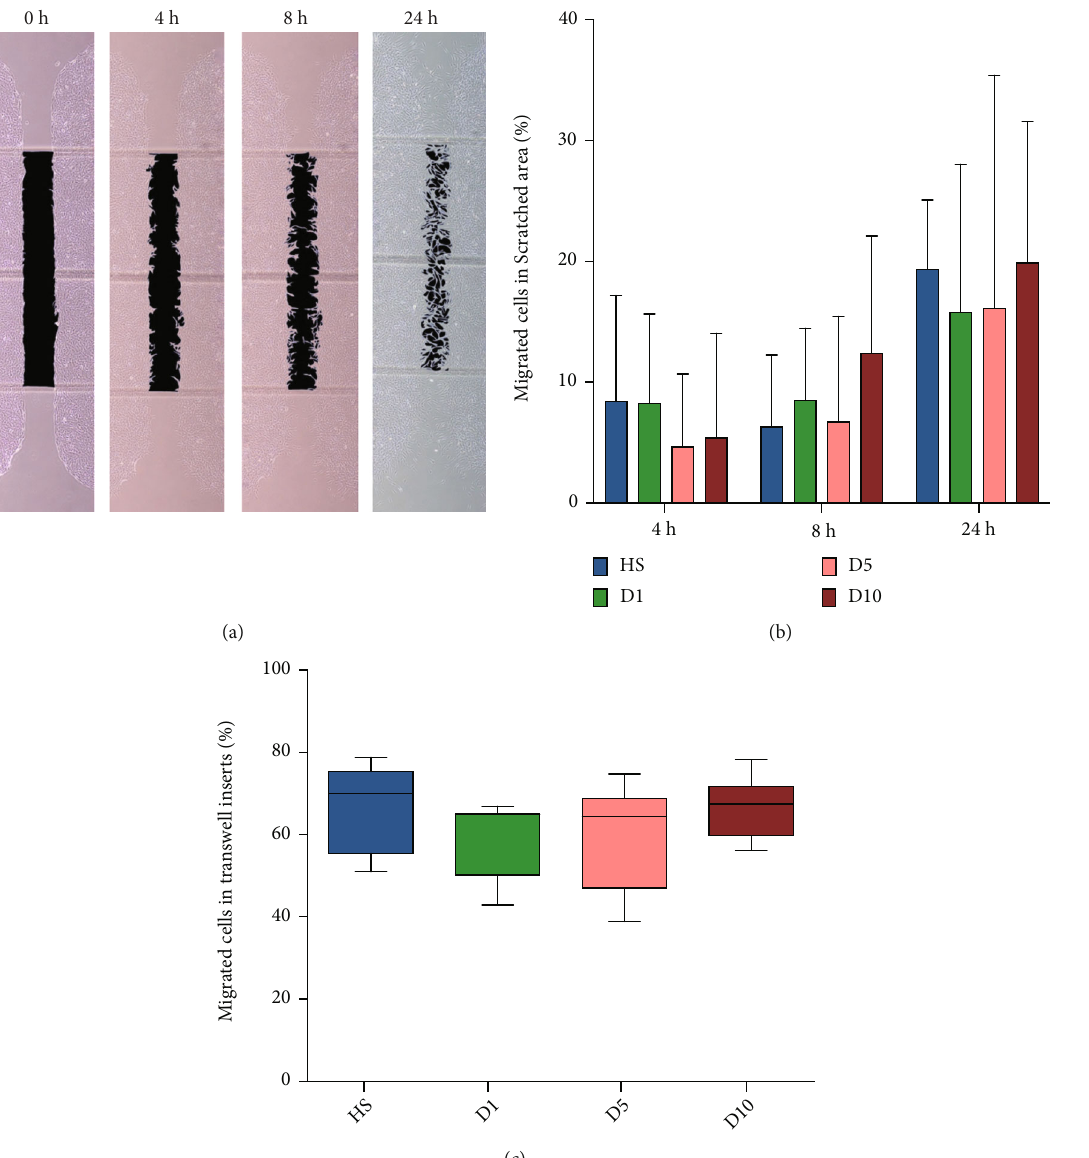
Figure 5: Scratch and transwell migration assay indicating the hBMSC repopulation ability. (a) Representative pictures of the migration and repopulation ability of hBMSCs over 24 hours treated with HS, D1, D5, and D10 sera in a scratch assay. The black area represents the scratched area. As time goes by, the injured area is gradually reduced and dispersed along with the migration of cells. (b) After 4, 8, and 24 hours, no signi fi cant increase in migration of the D1, D5, and D10 groups was found compared to the HS group ( n = 4 ; N = 2 ). (c) In transwell migration assay, no signi fi cant di ff erences in the ratio of migration were observed between the HS, D1, D5, and D10 groups 12 hours after seeding ( n = 4 ; N = 3